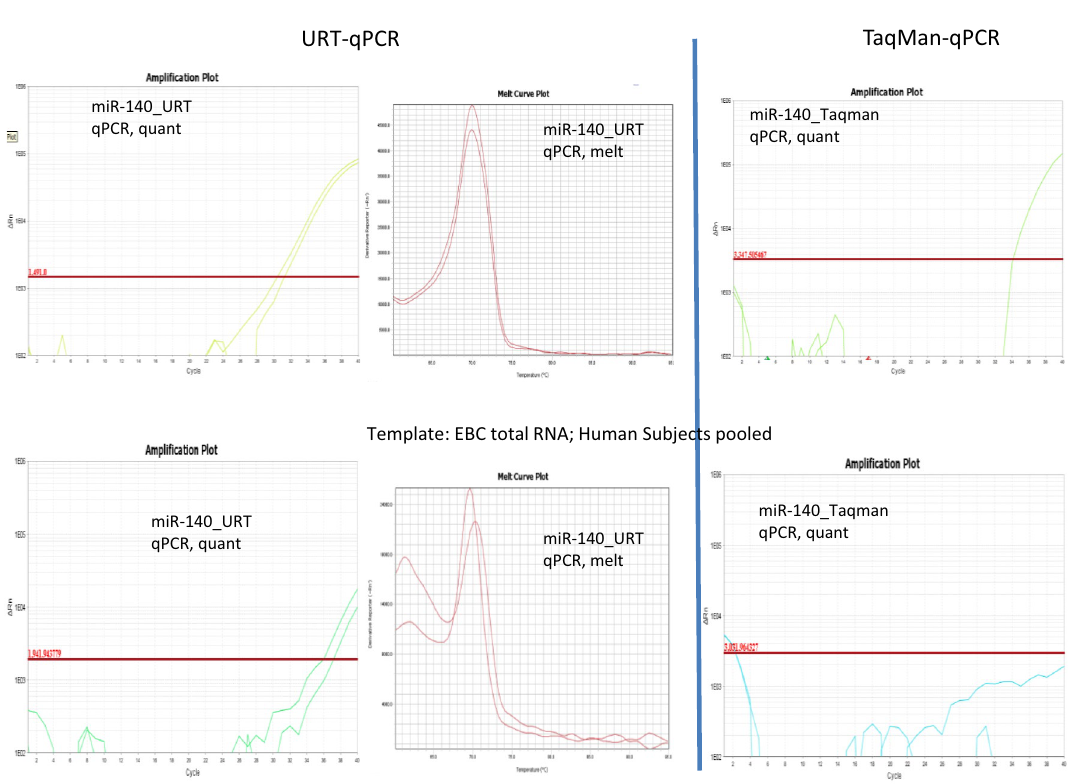
Figure 2. Verification of URT-PCR sensitivity. The relative sensitivity of the URT-PCR strategy was tested against the commercial standard (probe-based qRT-PCR (TaqMan). For six of ten direct comparisons, URT- PCR detected trqnscript, but TaqMan did not; examples (Panel A ) miR-140 and (Panel B ) miR-423-3p are shown. (Top) Total RNA (1 ng/ul) from a mixture of epithelial lung cells pooled was interrogated by both methods; URT-qPCR (left) showed CT 27 versus 31 for TaqMan, or 2^4 = 16-fold more sensitive. (Bottom) Total RNA extracted from EBC by conventional means (Methods) showed miR 423-3p as detectable by URT-qPCR, but absent by